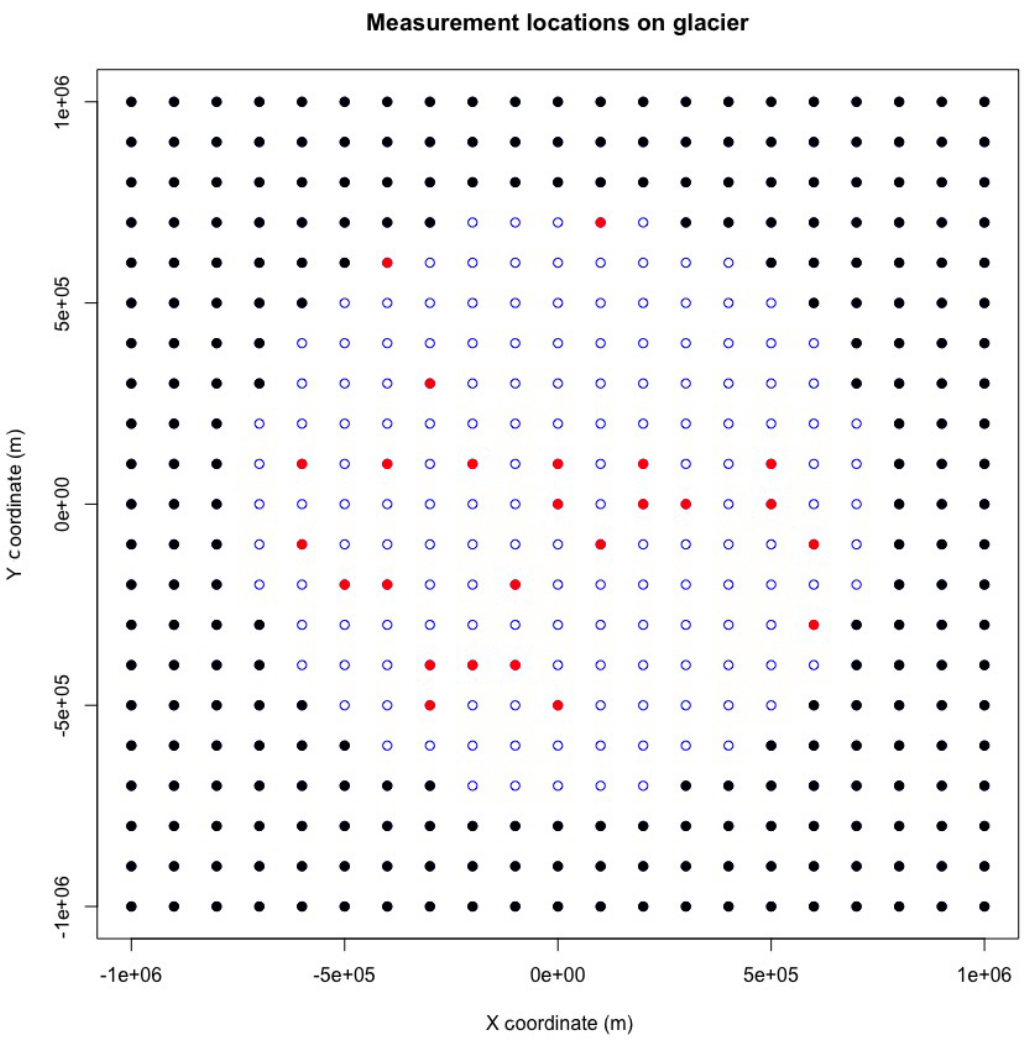
Figure 4. An illustration marking the 25 measurement sites on the glacier. This is a top level view of the glacier, where the blue points indicate the glacier, the red points indicate the measurement locations, and the black points indicate locations surrounding the glacier with no glacial